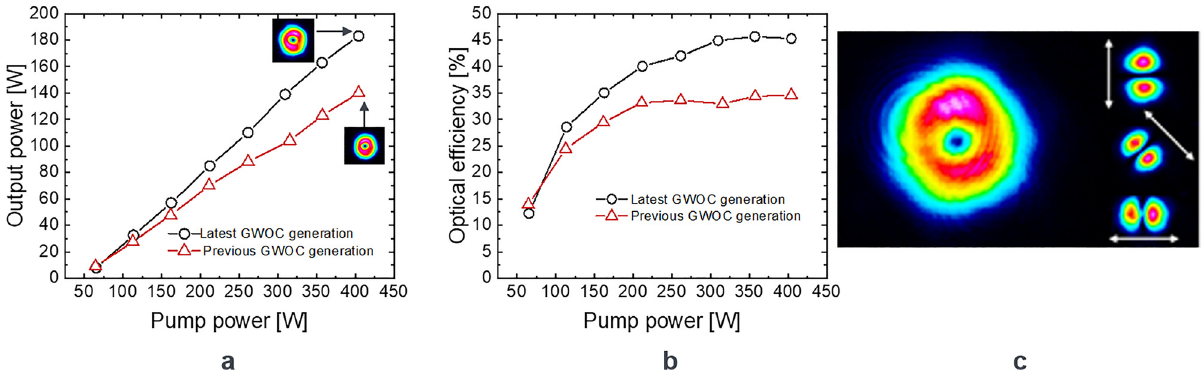
Figure 11: Laser performance comparing the two GWOC generations (left, middle) and qualitative analysis of the polarization of the output beam obtained with the new GWOC.